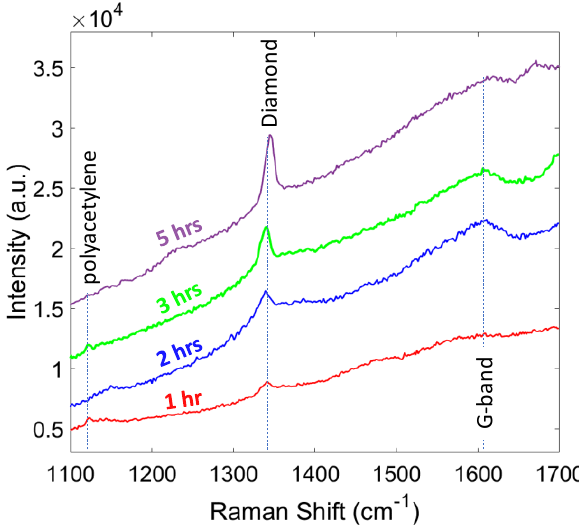
Figure 9. Raman spectra of the diamond films for different growth times. Table 4. Grain size, thickness, Raman peak, phase purity, and stress of diamond for different growth durations.